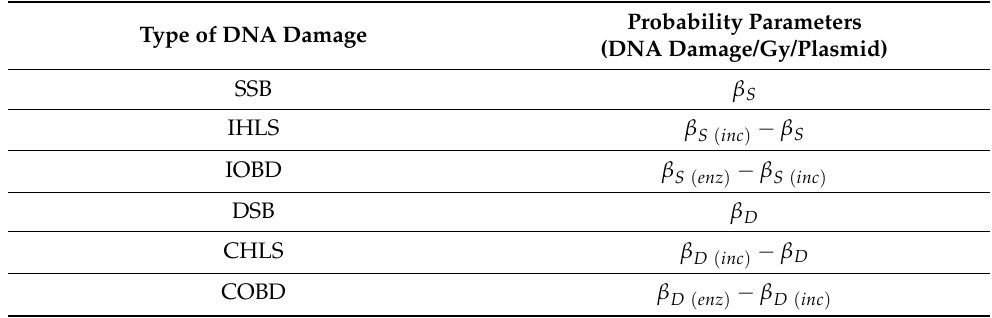
Table 6. Types of DNA Damage calculated from the probability parameters. Type of DNA